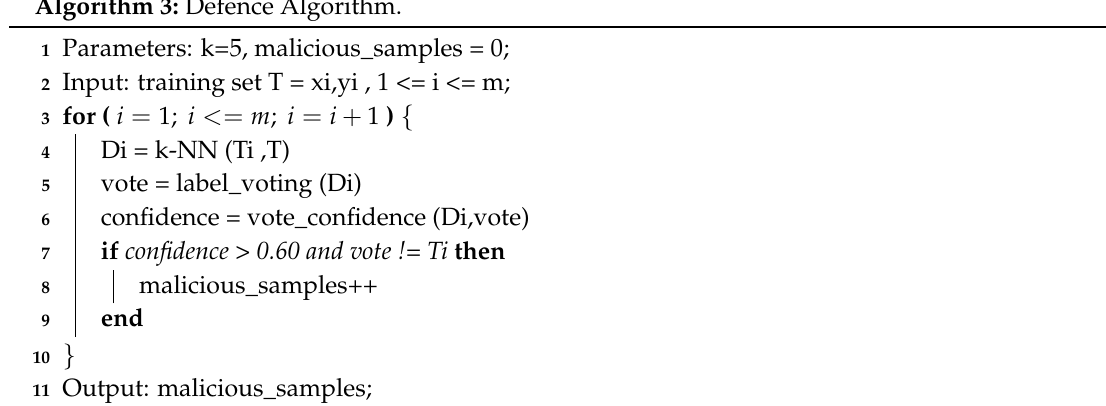
Algorithm 3: Defence